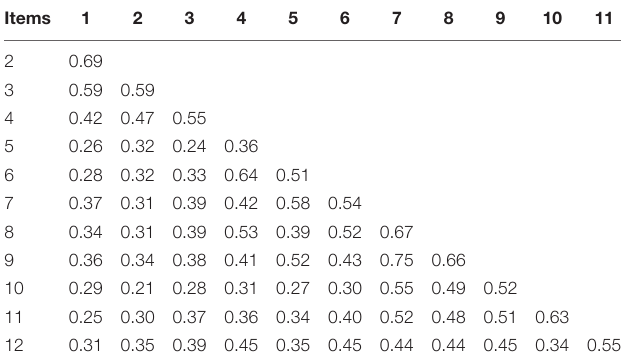
TABLE 4 | Polychoric correlation matrix for the Doctoral Student Identity Scale ( n =